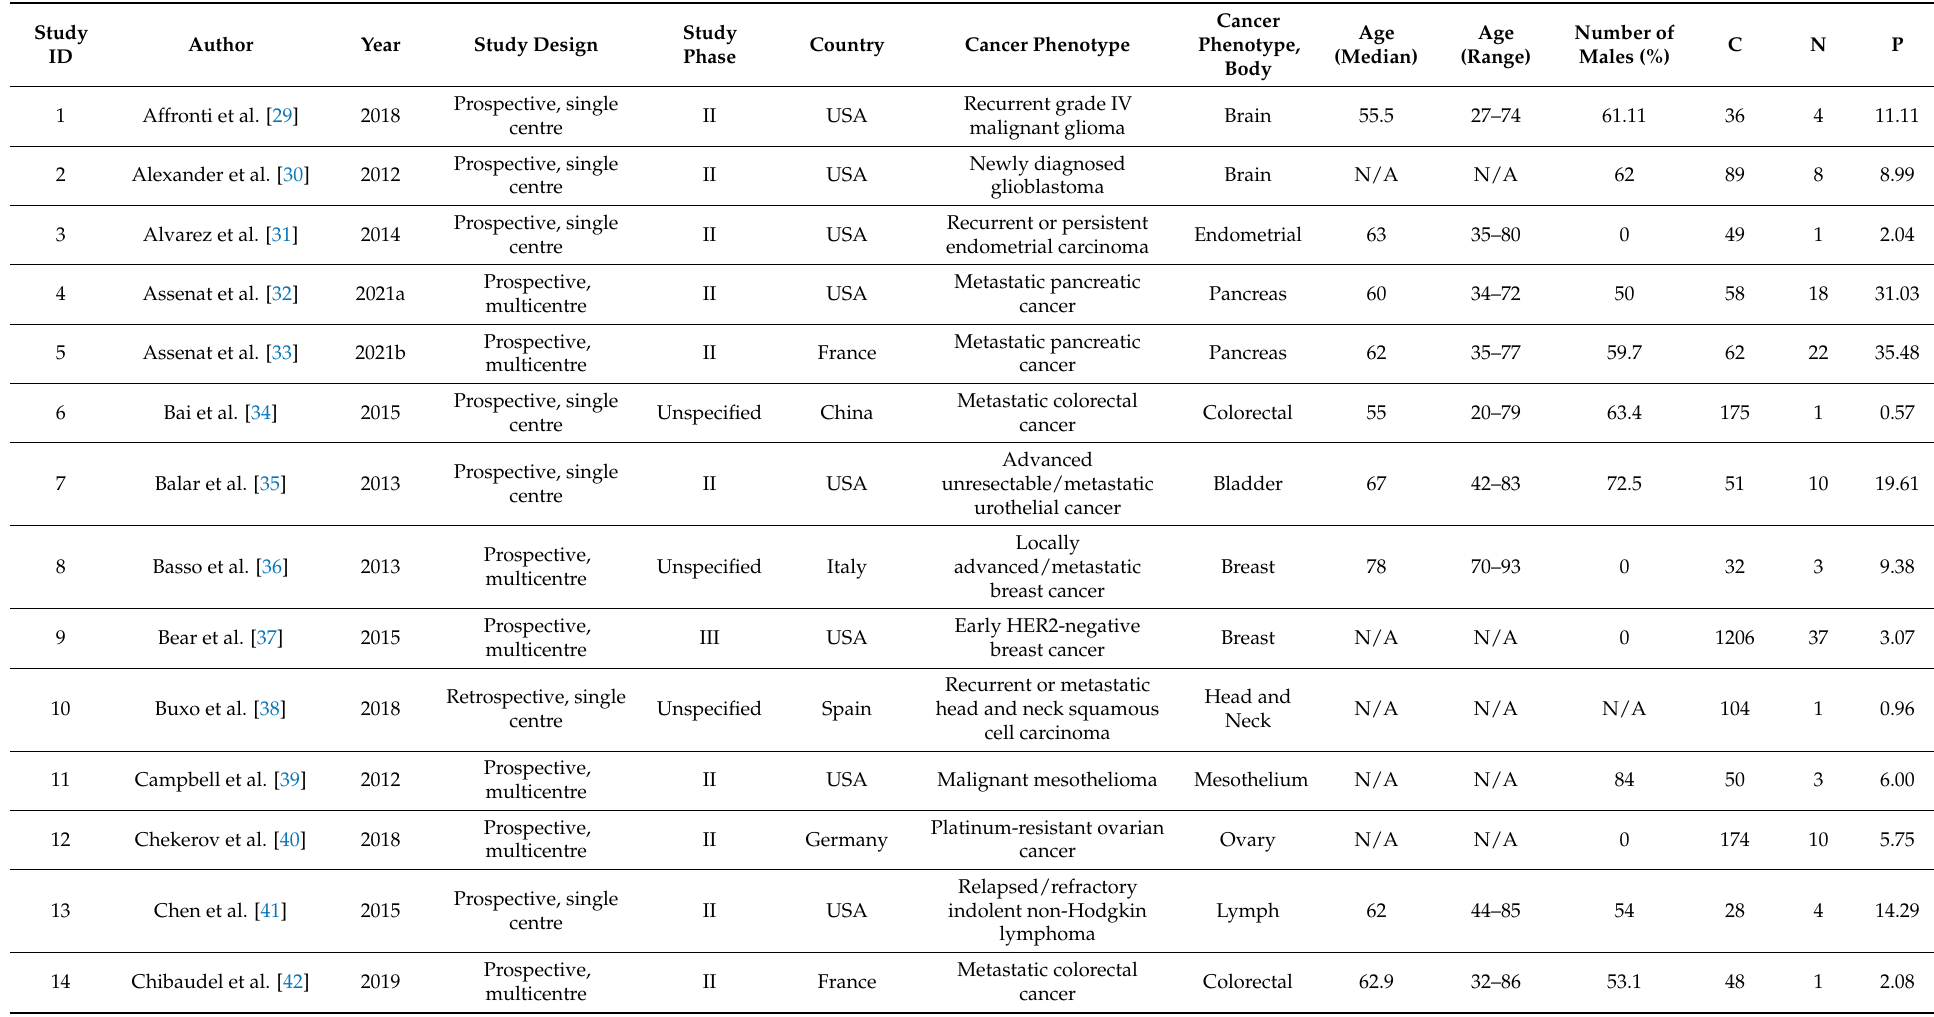
Table 1. Clinical characteristics of studies included in the